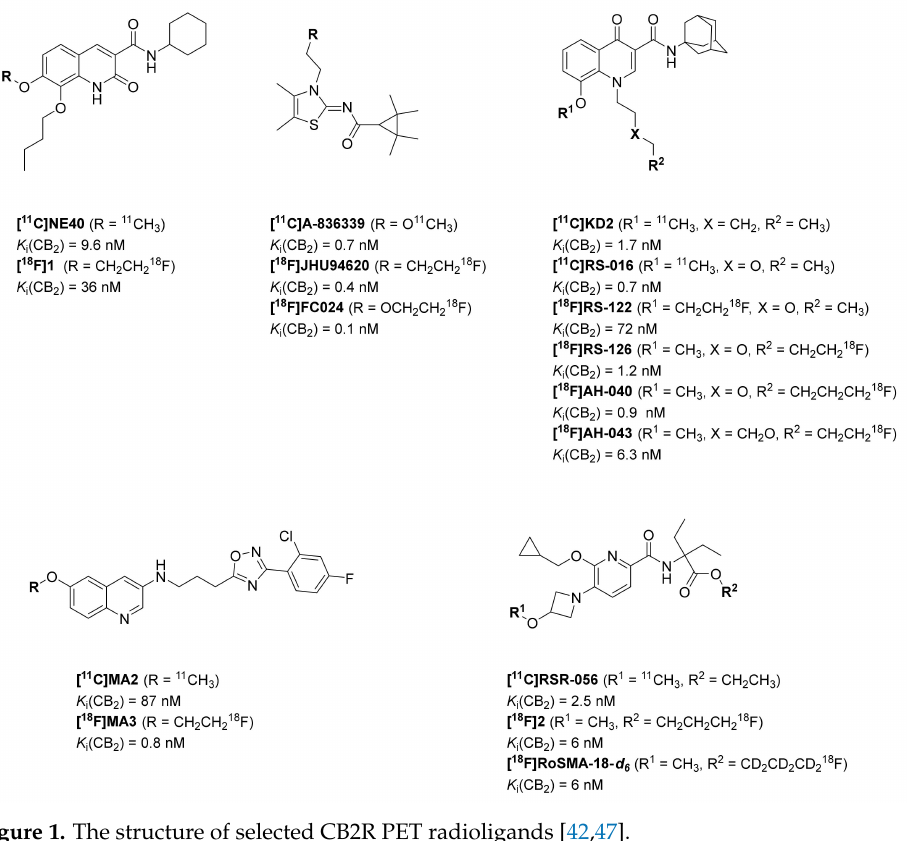
Figure 1. The structure of selected CB2R PET radioligands [42,47].